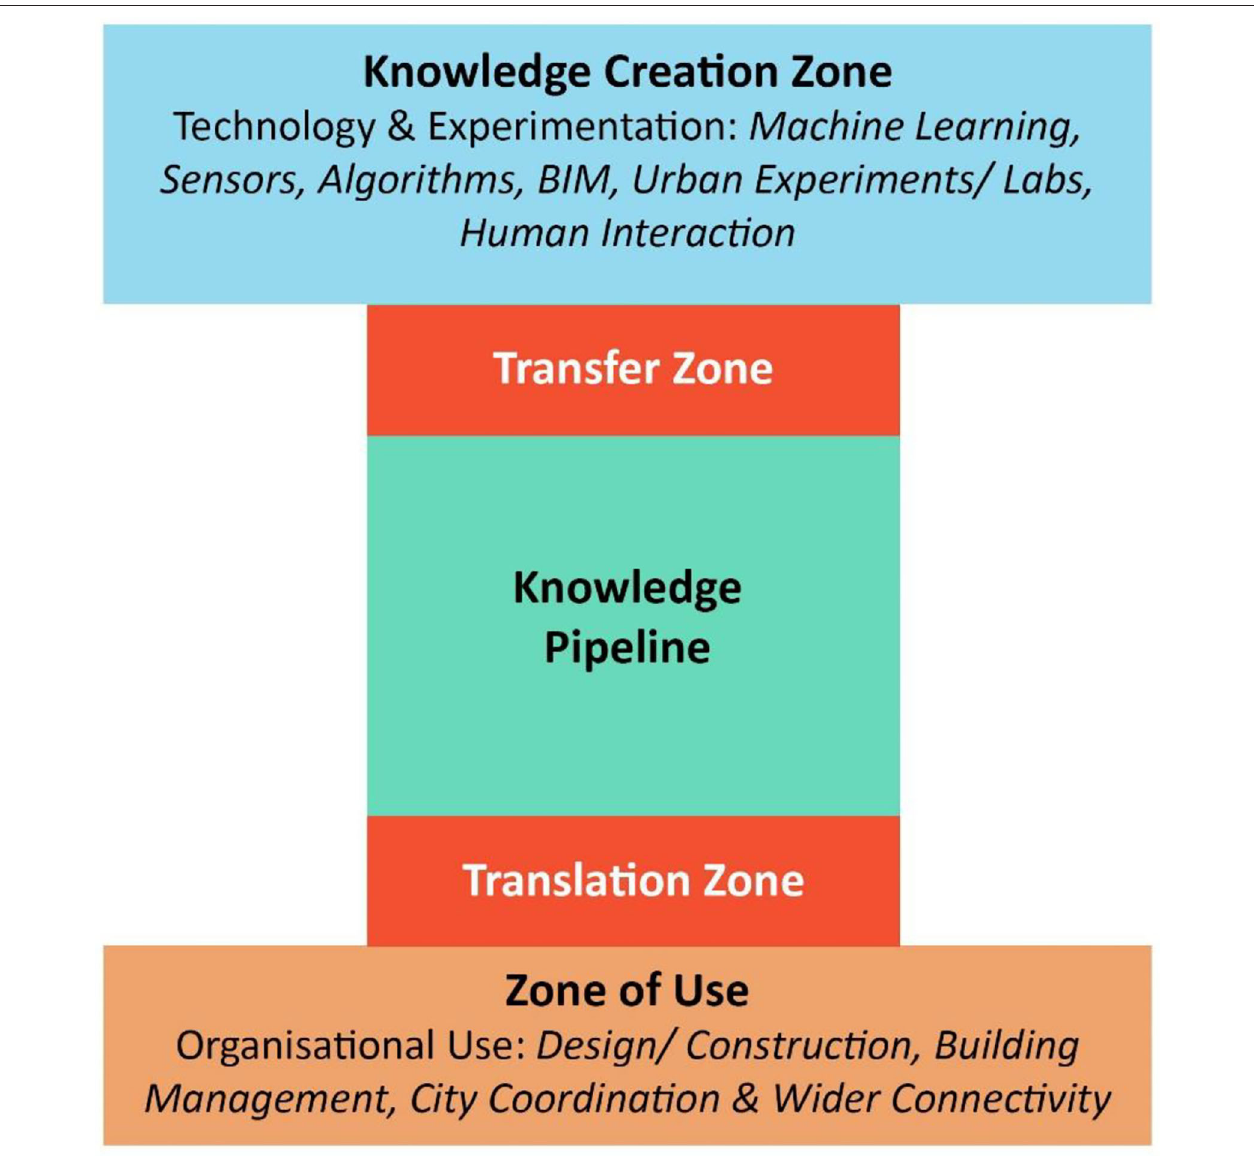
FIGURE 1 | The Knowledge Transfer in the Digital Built